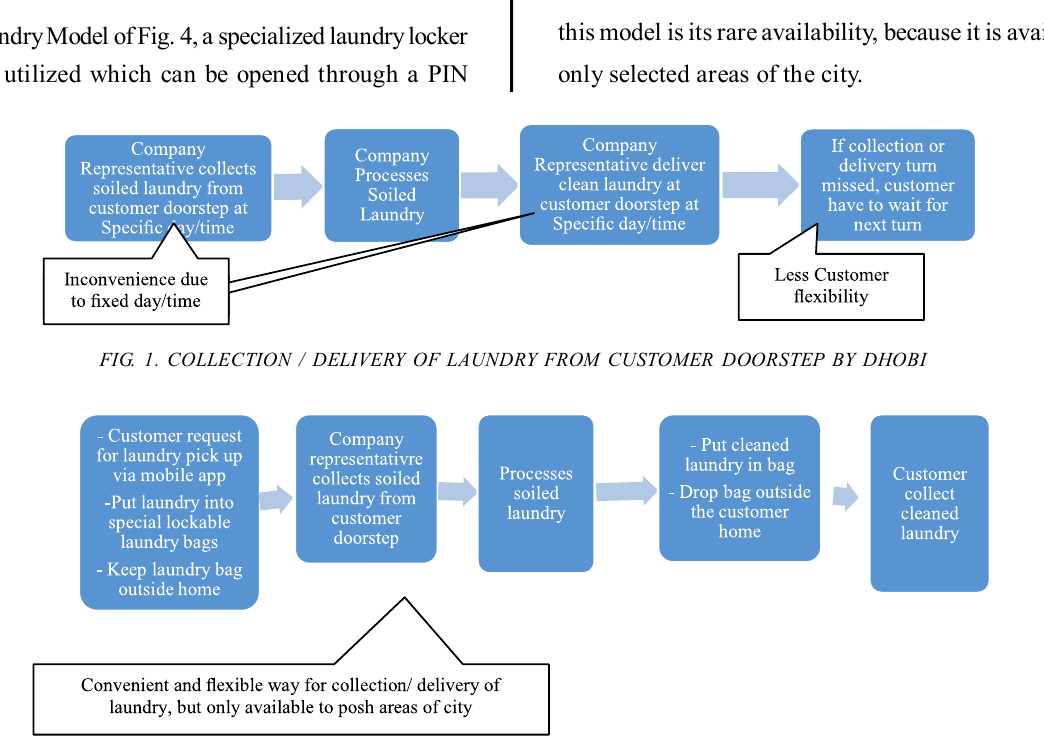
FIG. 2. COLLECTION / DELIVERY OF LAUNDRY FROM CUSTOMER DOORSTEP USING APP